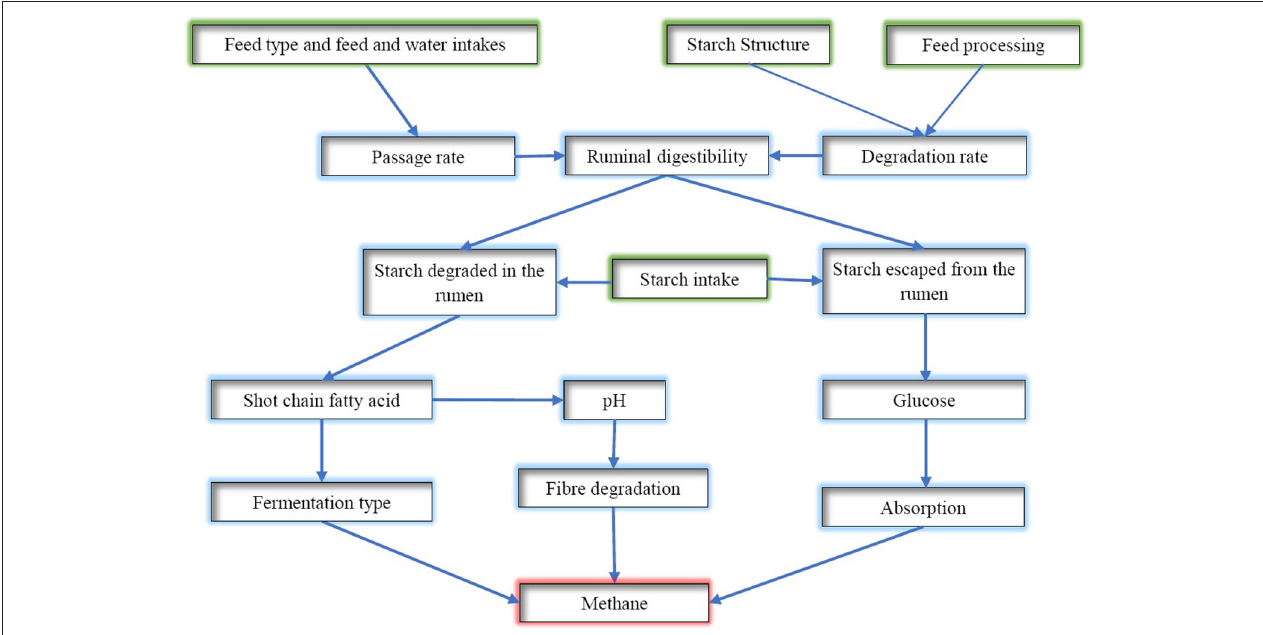
FIGURE 3 | A diagram of starch digestion in the rumen and its effects on methane emissions.